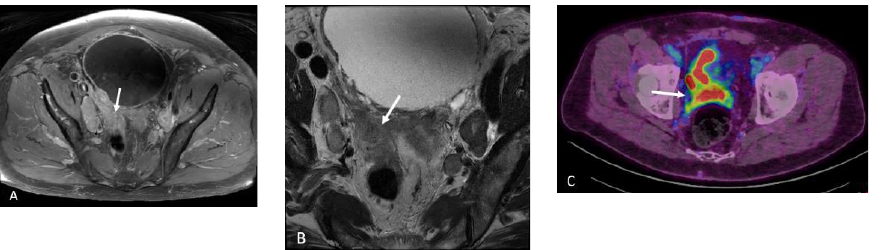
Figure 14. Seventy-nine-year-old male with history of Gleason 9 prostate cancer presenting for initial staging given high risk disease. Axial T1 post-contrast ( A ) and axial T2 ( B ) images demonstrate extra-prostatic extension of tumor into the right seminal vesicle and right pelvic sidewall (white arrows). Axial-fused 18F DCFPyL PET/CT ( C ) demonstrates intermediate- to high-grade activity extending to these regions (white arrows), consistent with miT4 disease.